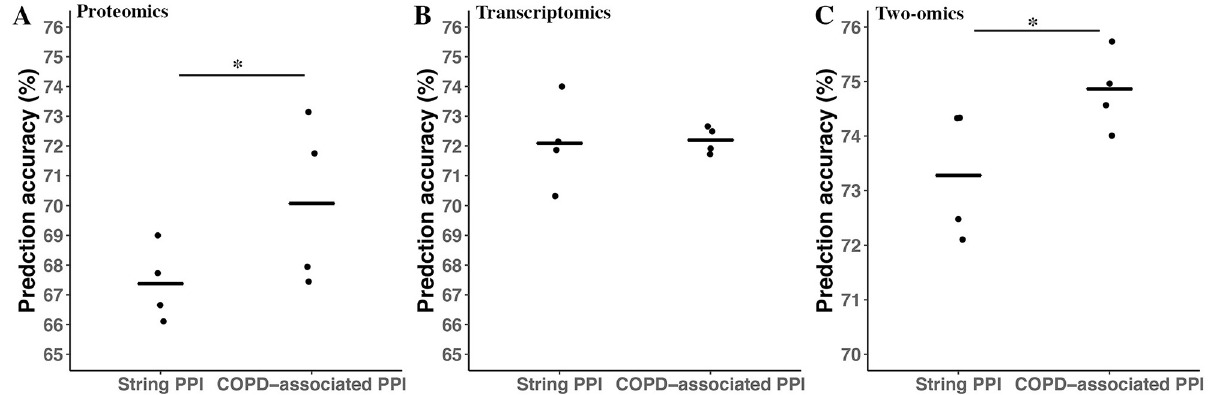
Fig 5. ConvGNN performance with COPD-associated PPI by AhGlasso. The ConvGNN models were trained in a 4-fold CV strategy as above on the proteomics data (A), transcriptomics data (B), or both (C). The PPI network for ConvGNN was either retrieved from the STRING database or COPD- associated PPI with AhGlasso. The model performances are assessed using the prediction accuracies on the testing dataset. The lines represent the mean accuracies for CV-trained models. The differences between conventional classification models are tested with paired student’s t-test ( * , P � 0.05).